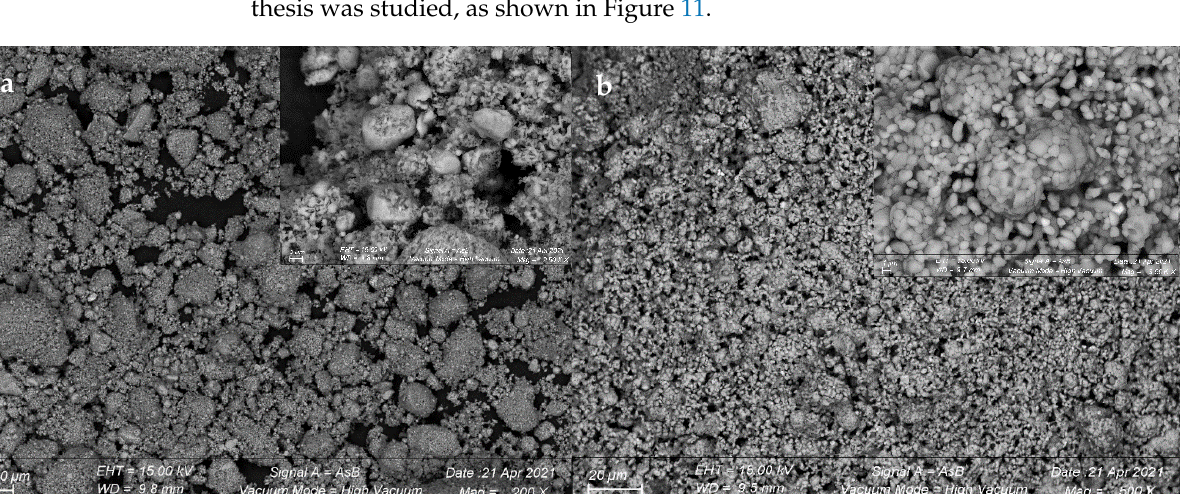
mechanosynthesis at ( a ) 900 °C ( b ) 1200 °C.